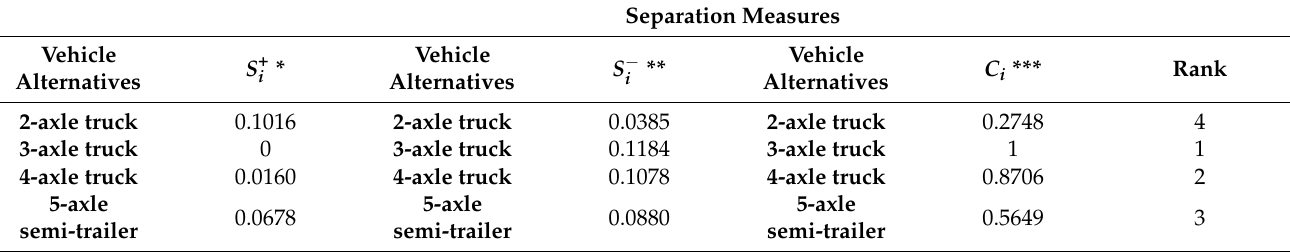
Table 22. Final ranking of the vehicle